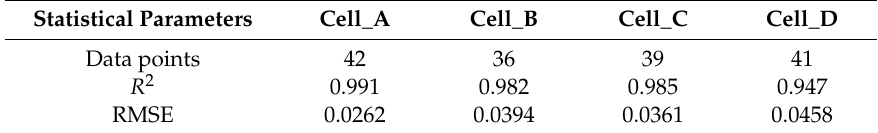
Table 2. R 2 and RMSE of the SOH estimations of all cells using cell A for the model construction. Statistical Parameters